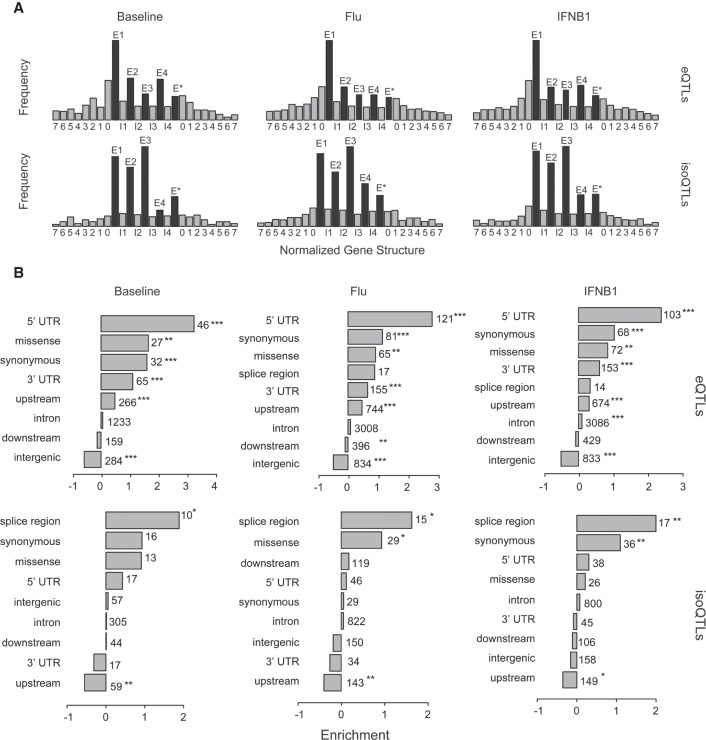
Properties of local eQTLs and isoQTLs. (A) Frequency (y-axis) of the location of leading SNPs for local eQTLs and isoQTLs (permutation FDR < 0.05) with respect to meta gene structure (x-axis). Genes are normalized to five exonic regions (E1–E4 indicate exons 1 through 4; E* indicates exon 5 to the last exon) and four intronic regions (introns 1, 2, 3, and from intron 4 to the last intron). Upstream and downstream sequences are divided into 100-kb windows. (B) Log2 fold enrichment (x-axis) of leading SNPs for local eQTLs and isoQTLs (permutation FDR < 0.05) for genomic annotations. eQTL enrichments are calculated using a background set of SNPs matched for distance to TSS and allele frequency. IsoQTL enrichments are calculated with respect to a background set of eQTLs matched for distance to TSS and allele frequency. Multiple testing significance is indicated. (*) P < 0.05; (**) P < 0.01; (***) P < 0.001.